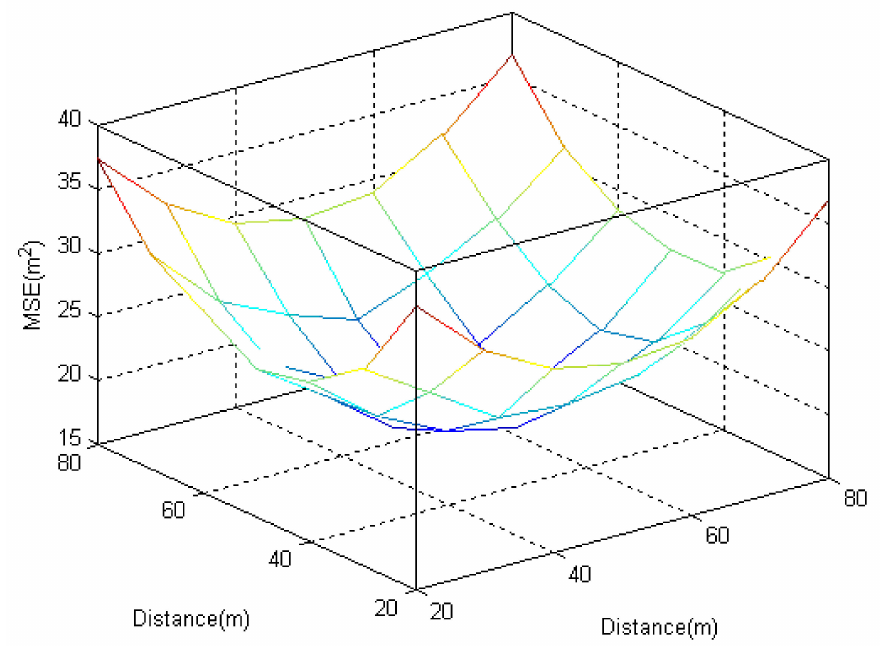
Figure 19. Six reference nodes to estimate small